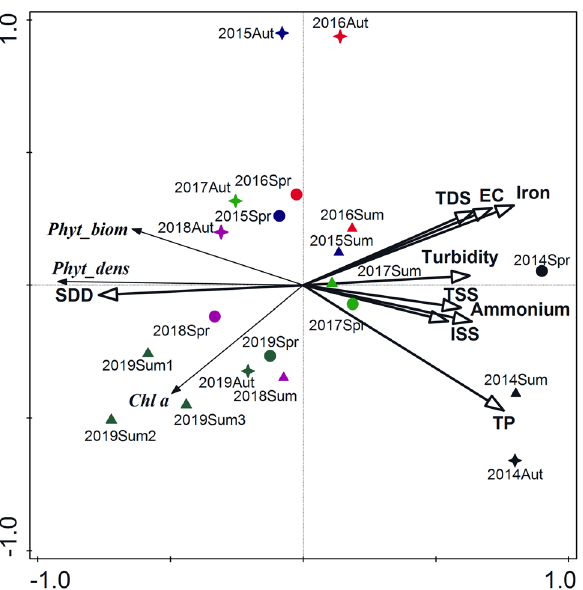
Figure 3. Triplot diagram of RDA for phytoplankton density, biomass, and chlorophyll a content and main environmental variables in the Kuźnica clarification pond in 2014–2019. Phyt_biom phytoplankton biomass, Phyt_dens phytoplankton density, Chl a chlorophyll a content, EC electrical conductivity, TDS total dissolved solids, TSS total suspended solids, ISS inorganic suspended solids, turbidity, SDD Secchi disk depth, ammonium, TP total phosphorous, Fe iron.